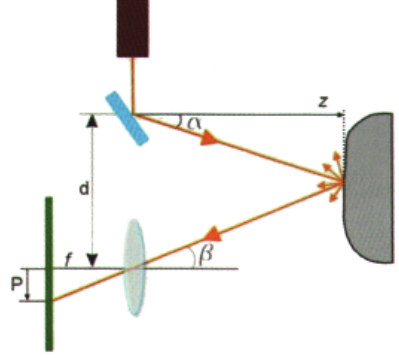
Figure 2. Basic geometrical principle of triangulation-based laser scanners (Bitelli, 2009).